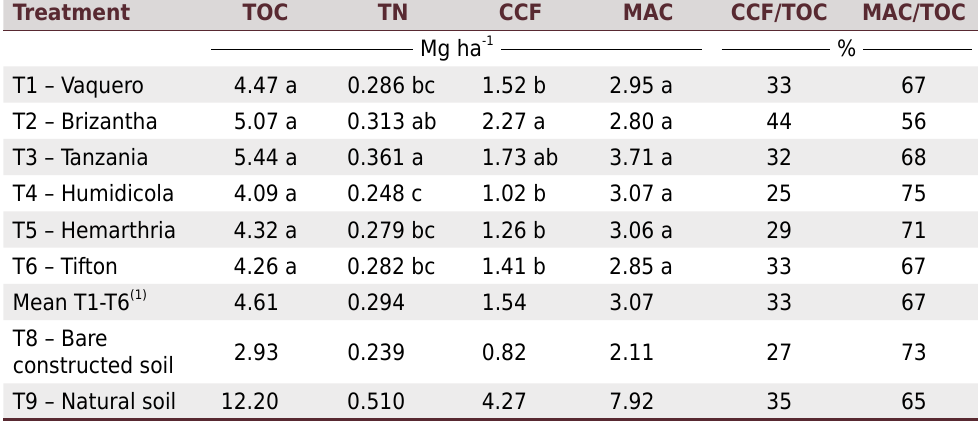
Table 2. Stocks of total organic carbon (TOC), total nitrogen (TN), carbon stock in the coarse fraction (CCF), mineral-associated carbon (MAC), and CCF/TOC and MAC/TOC ratios in the 0.00-0.03 m layer of a constructed soil covered with different grass species, a bare constructed soil and a natural soil (unmined, with native vegetation) Treatment TOC